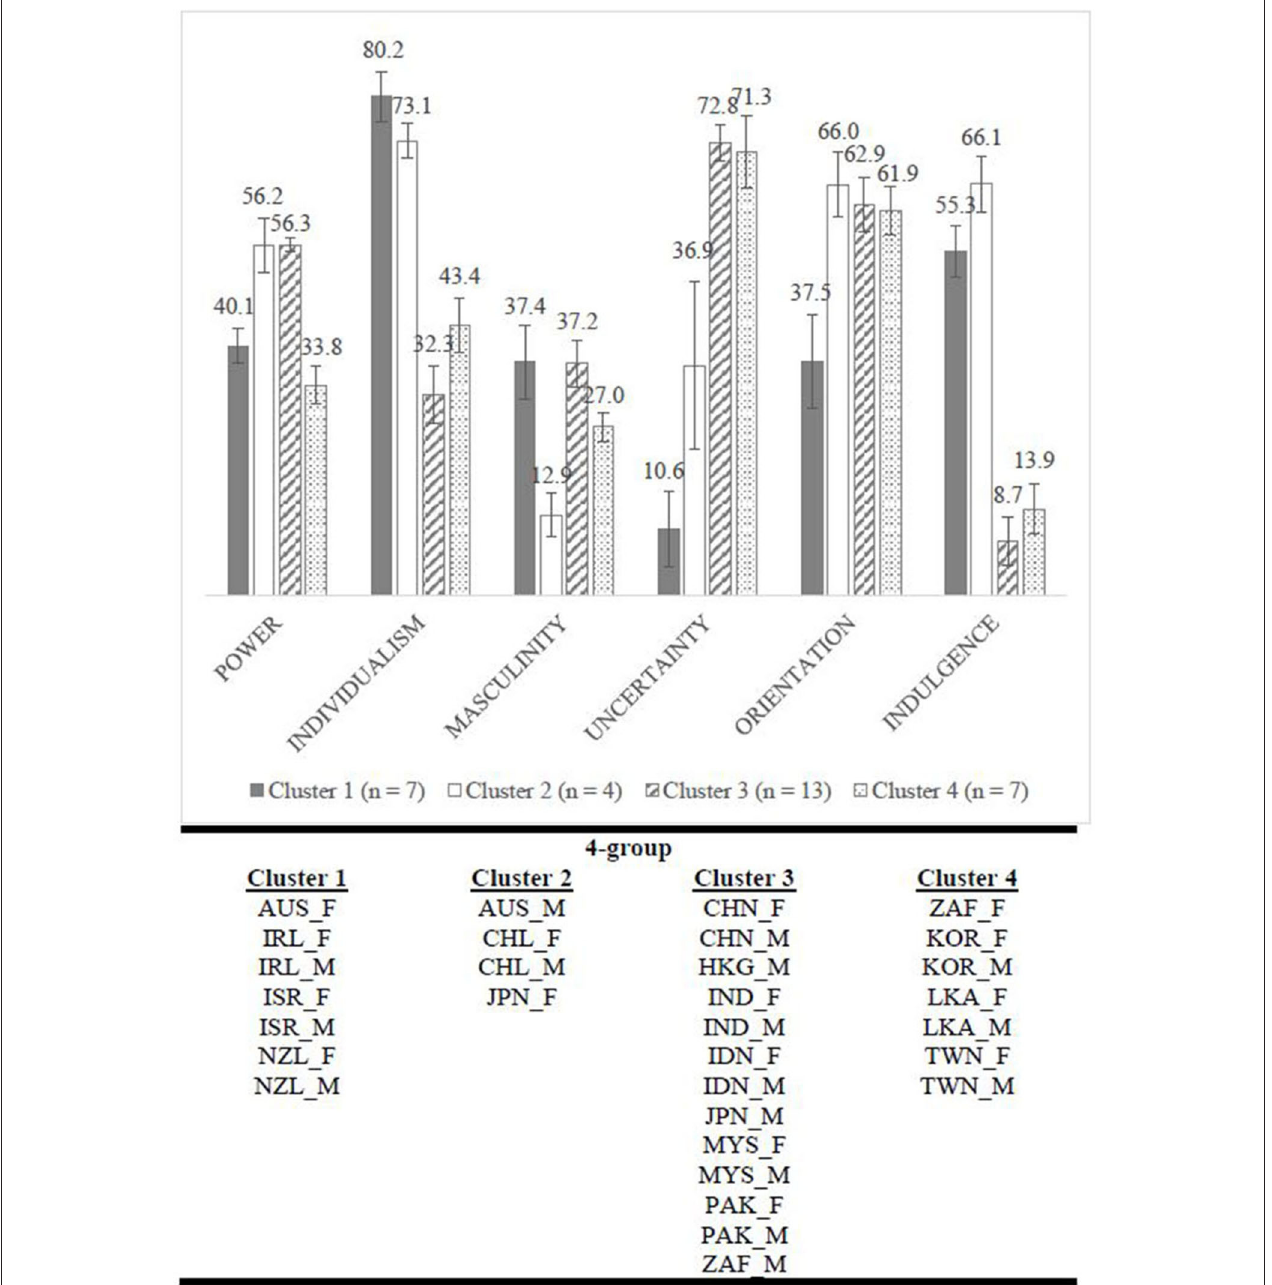
FIGURE 3 | Overall pattern of clusters’ characteristics based on Hofstede’s six cultural dimensions by gender. Mean scores by cluster and error bar represented 95%